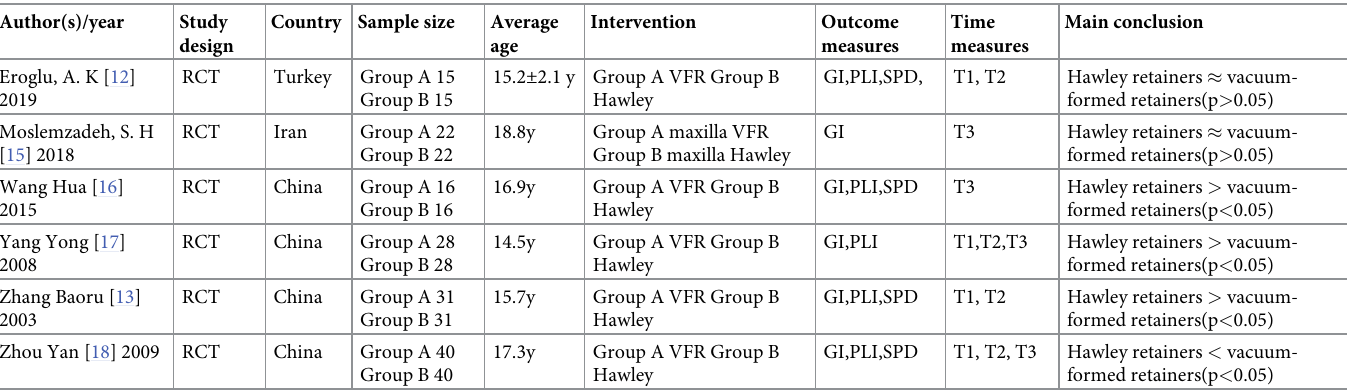
Table 3. Characteristics of the included studies.